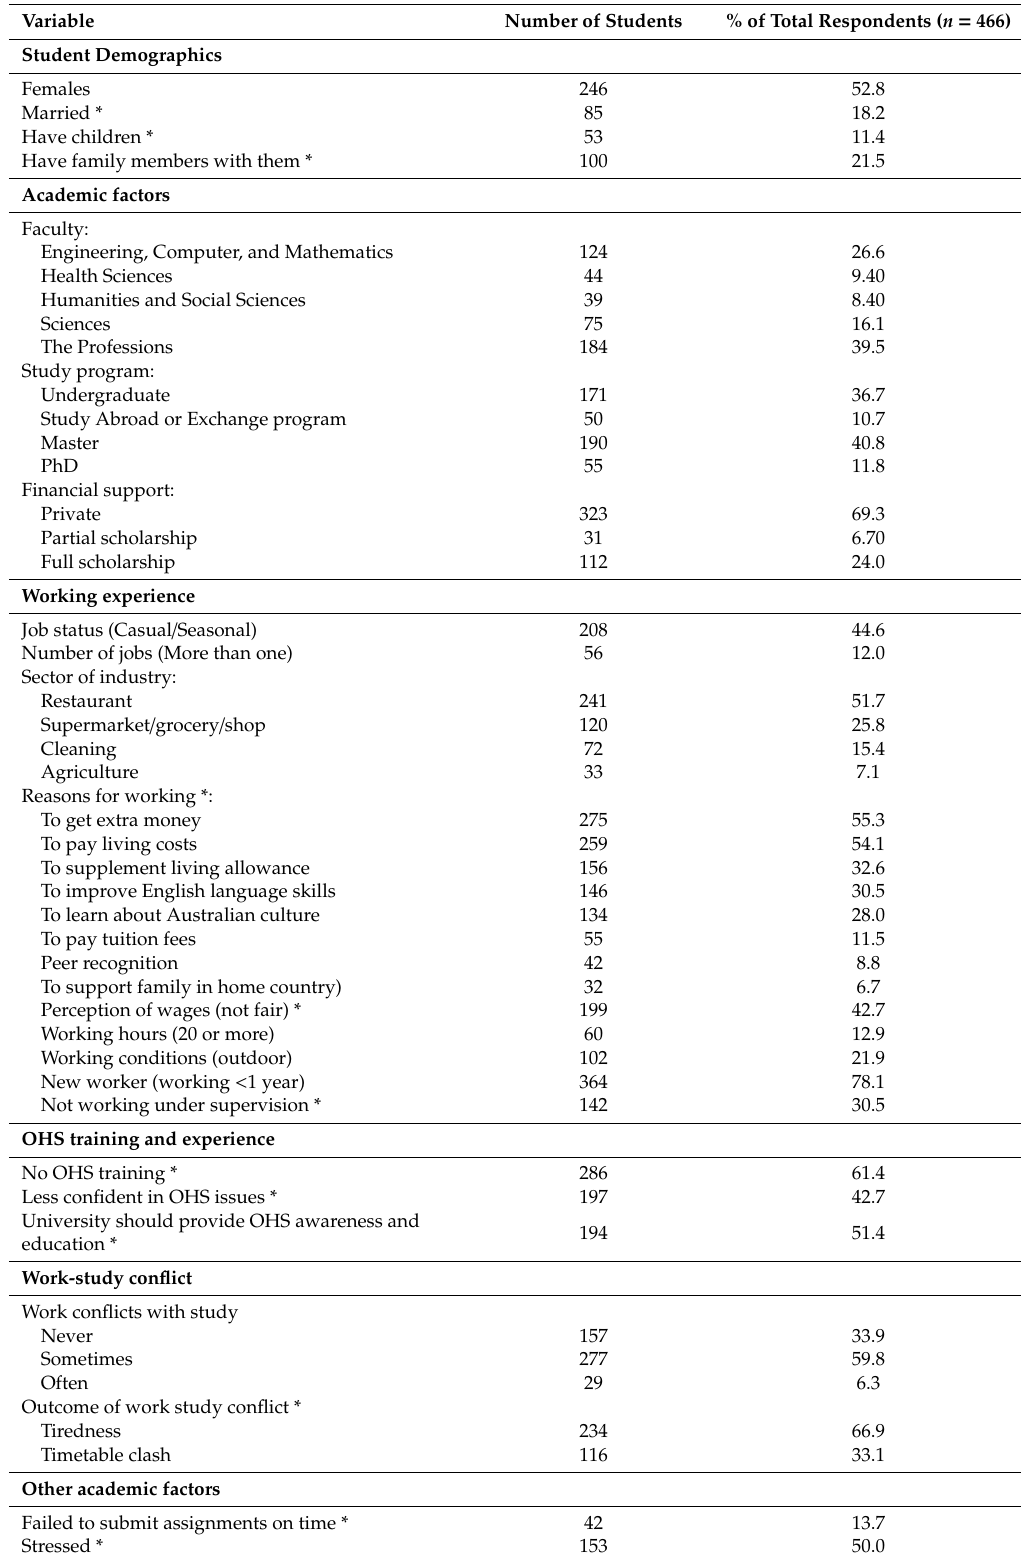
Table 1. International student worker characteristics and